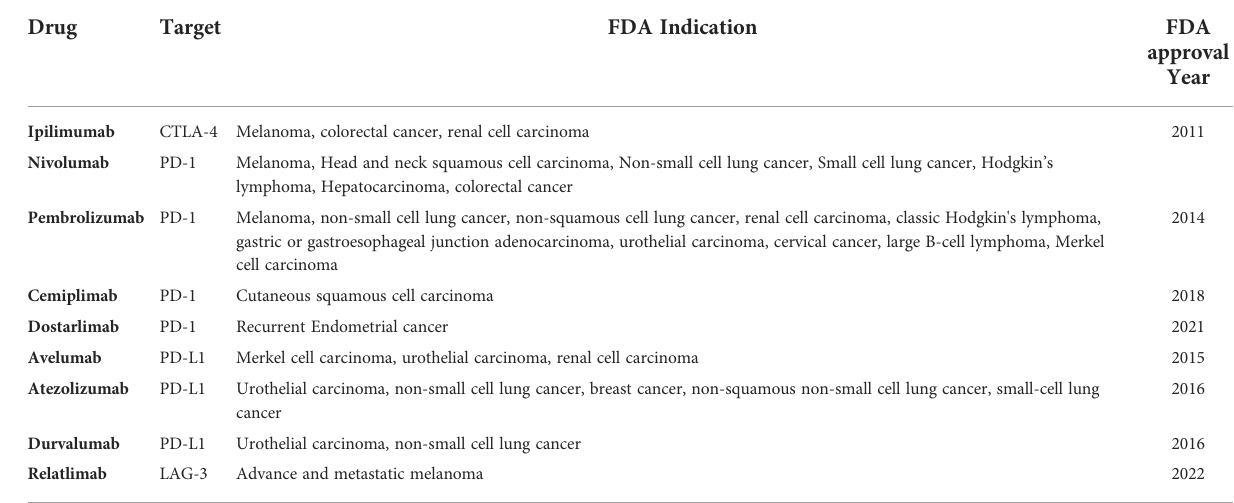
TABLE 1 Current FDA approved Immune Checkpoint Inhibitors and their